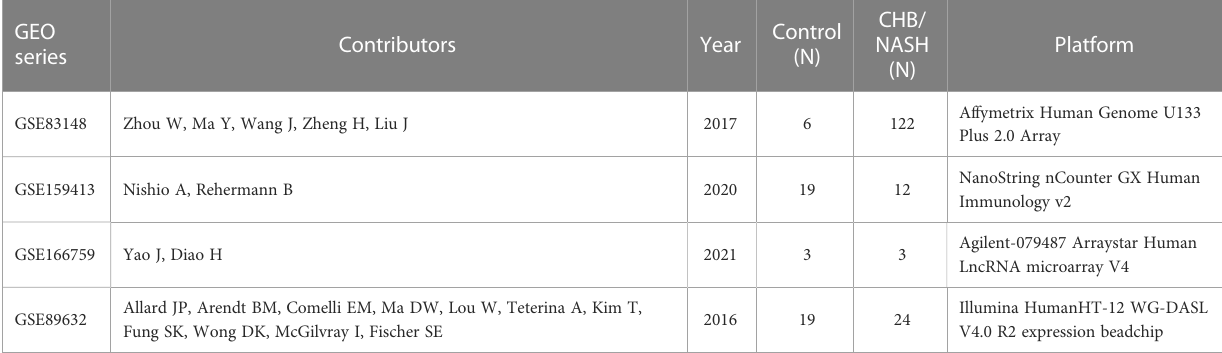
TABLE 1 Details of four GEO cohorts used in this study.